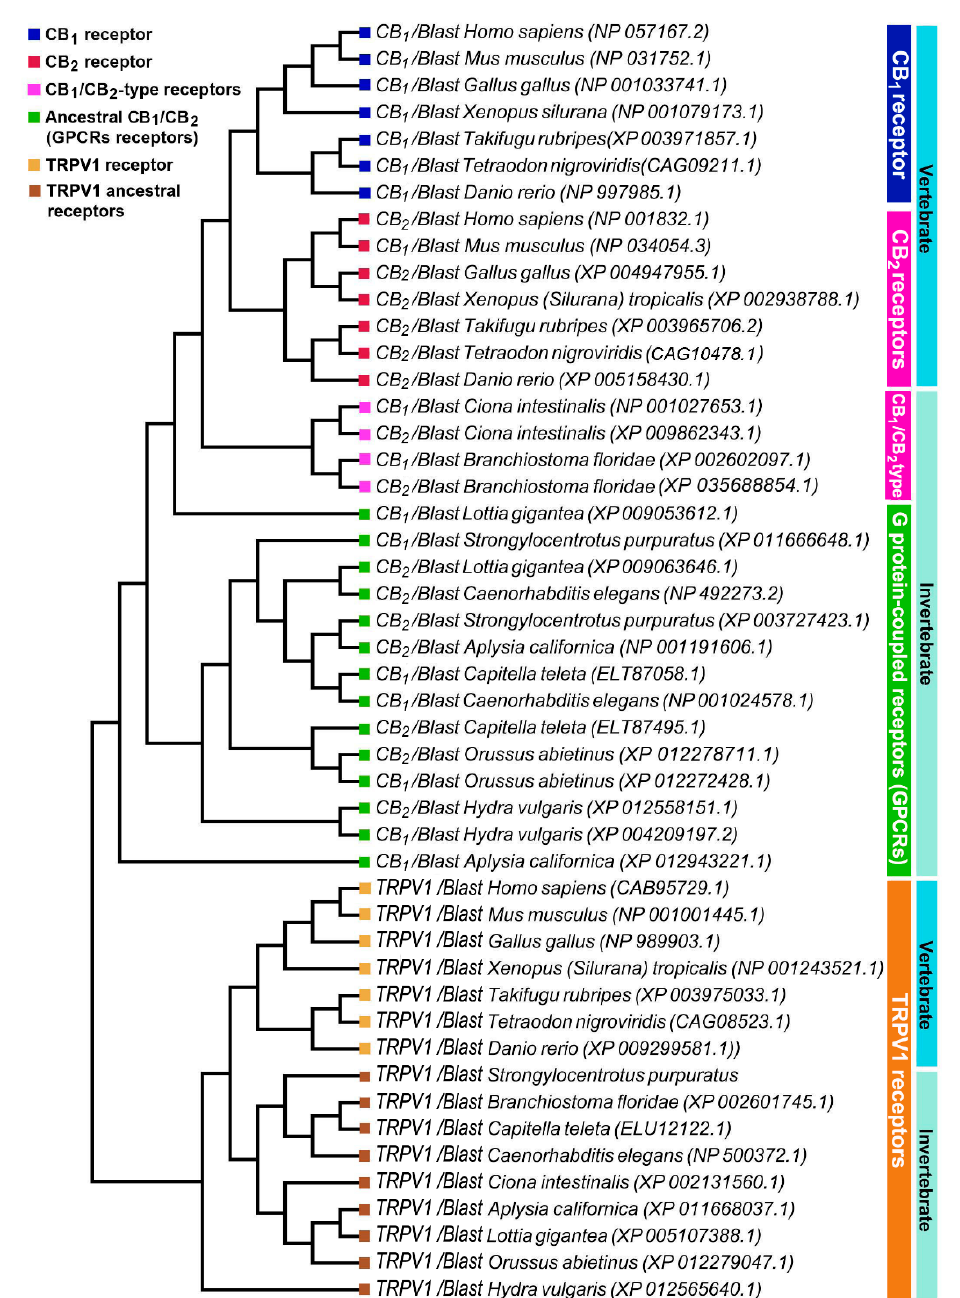
Figure 3. Phylogenetic analysis of vertebrate and invertebrate cannabinoid CB 1 , CB 2 , and TRPV1 receptors.